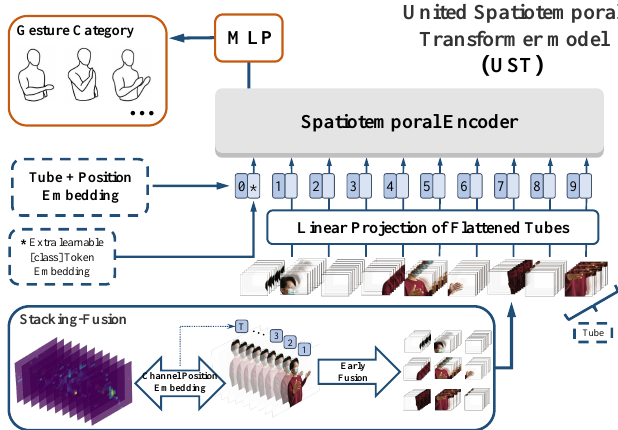
Figure 10. United spatiotemporal transformer model, where * is the [class] token. Stacking-fusion. To strengthen the fitting capability of SST in high dimensional feature space, a 3D BVP sequence S BVP ∈ R T × H × W is stacked as a 2D “image” S BVP ∈ R H × W × C whose channels are filled with frames of BVPs ( C = T ), which fuses the temporal and spatial feature maps in digital images. Feature maps do not contain order and interrelationships, whereas BVPs do. For this reason, we selected 3D tubes rather than 2D windows, such as for the position